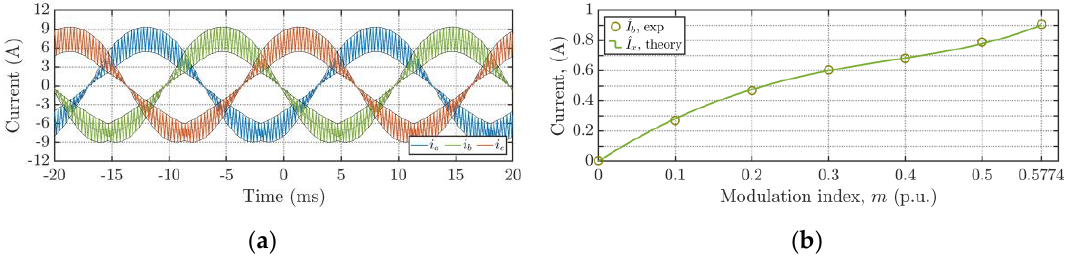
Figure 37. ( a ) Phase currents with primary (black) and secondary (gray) envelopes in case of